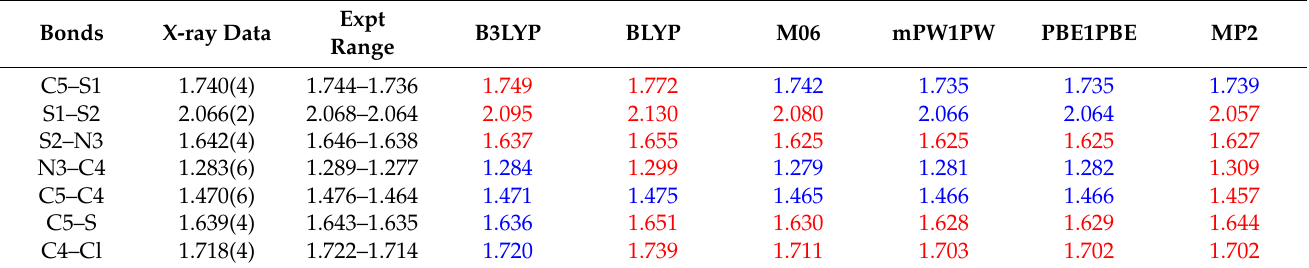
Table 5. Experimental and computational bond lengths (Å) of the dithiazolethione 2c a